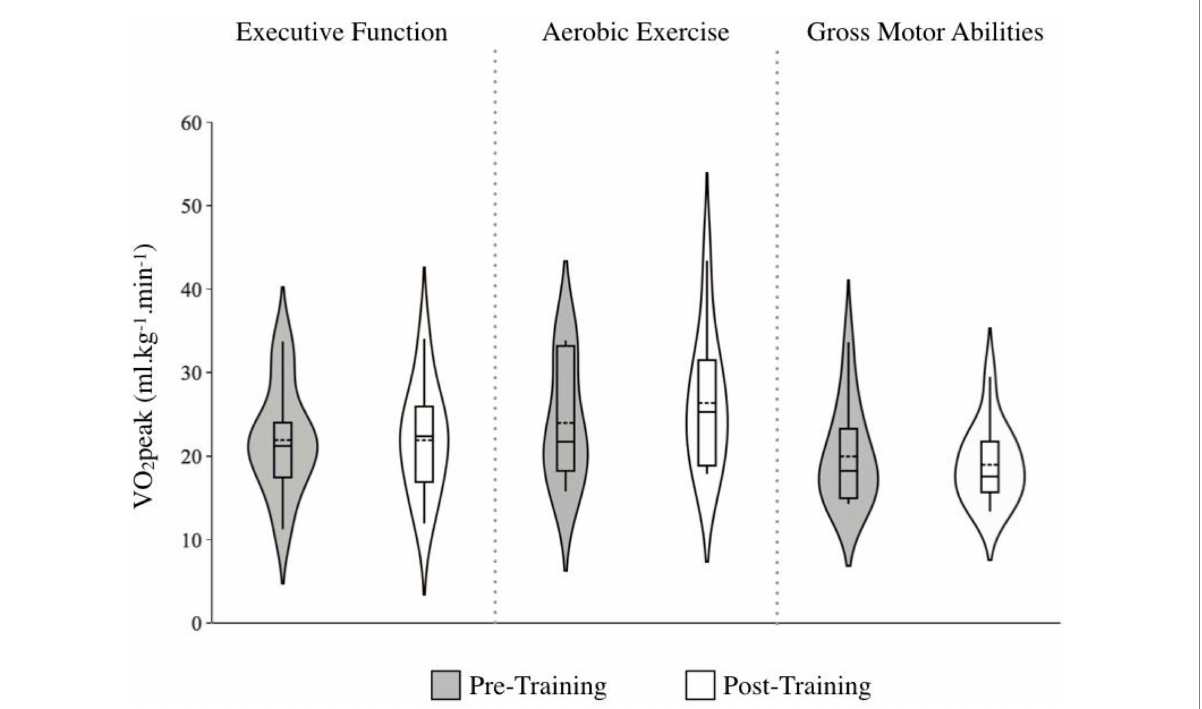
FIGURE 6 Marker of cardiorespiratory fitness (i.e., VO2peak) before and after training across training groups. Note. Higher scores indicate better cardiorespiratory fitness. The length of each curve represents the range of scores, the width represents the frequency of data points in each region, the solid line within each boxplot represents the median, and the dotted line represent the mean. While VO 2peak improved following aerobic exercise training ( g = 0.31 [small effect] ∆ = 9.07%), the interaction effect only approached significant. As the aerobic exercise group had the highest VO 2peak levels at baseline, this may have limited the possibility for further improvement through